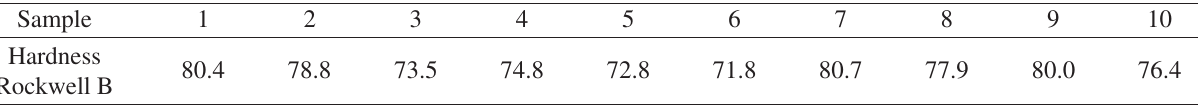
Table 2. Hardness Rockwell